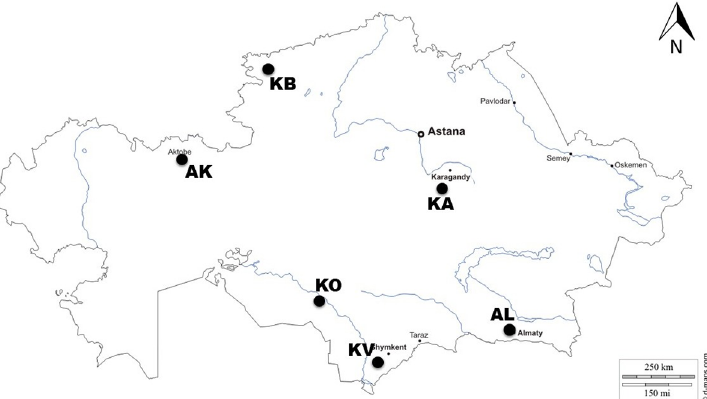
Fig 1. Locations of field trials at six breeding stations in Kazakhstan. KB–Karabalyk breeding station (North Kazakhstan), AK–Aktobe breeding station (West Kazakhstan), KA–Karaganda breeding station (Central